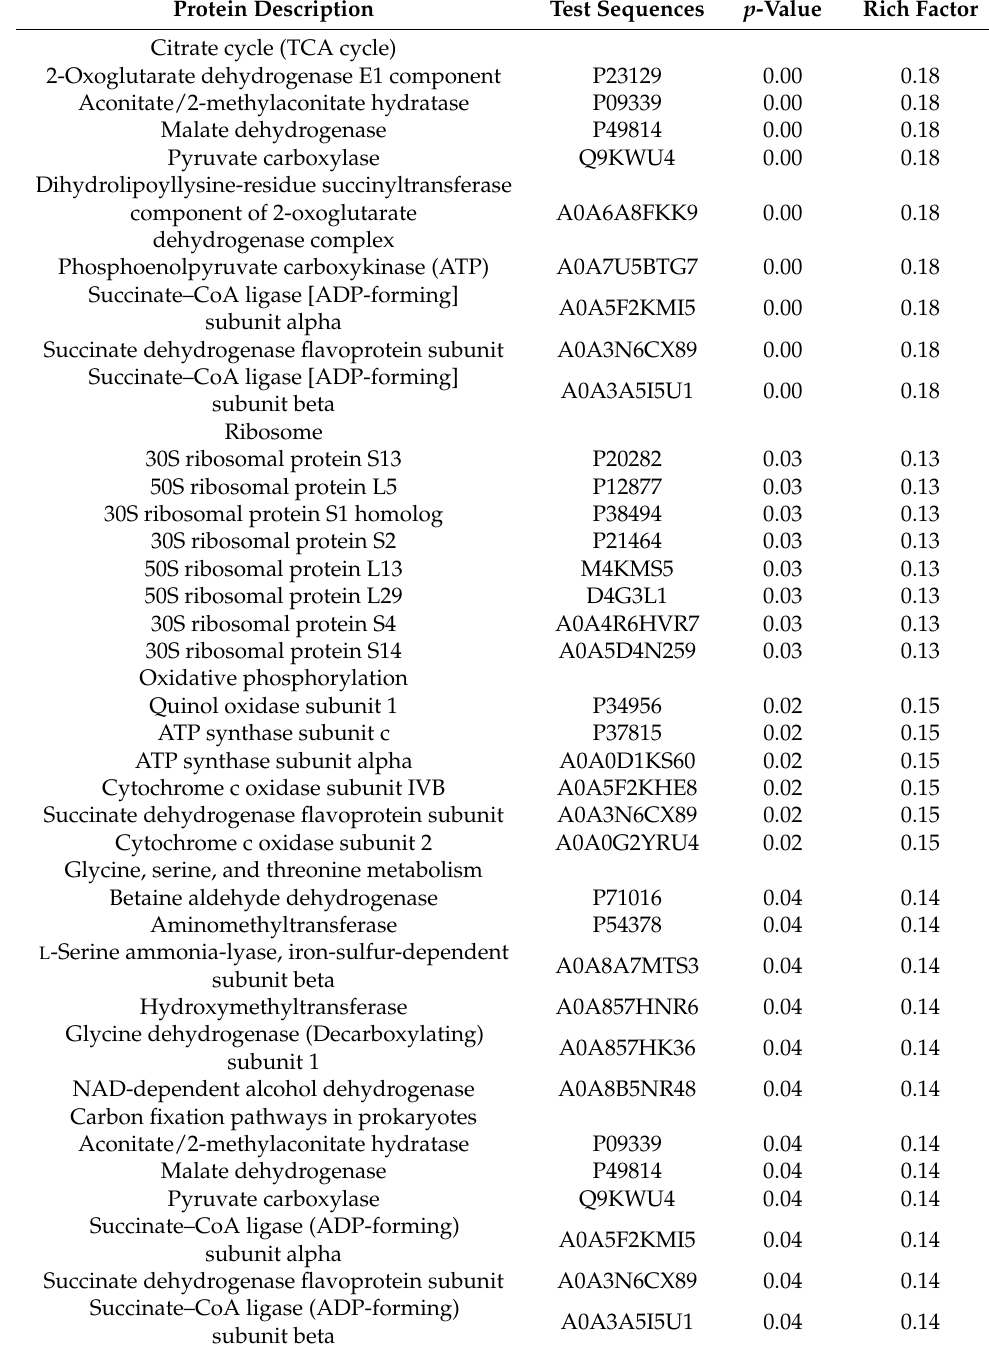
Table 2. The respective DEPs in B. subtilis spores against P